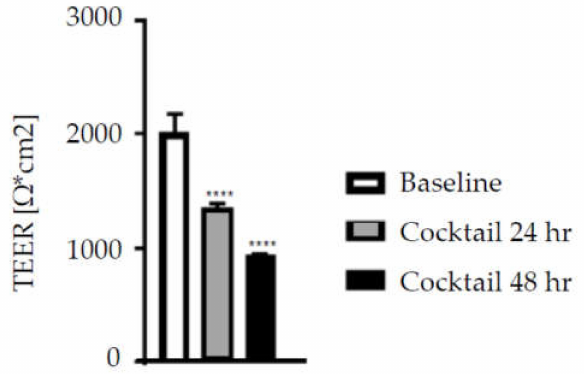
Figure 3. TEER measurements of Caco-2 cell cultures exposed to a cocktail of inflammatory cytokines on the basolateral side for 24 or 48 h. Data are mean + SEM ( n = 9). **** p < 0.0001 vs.